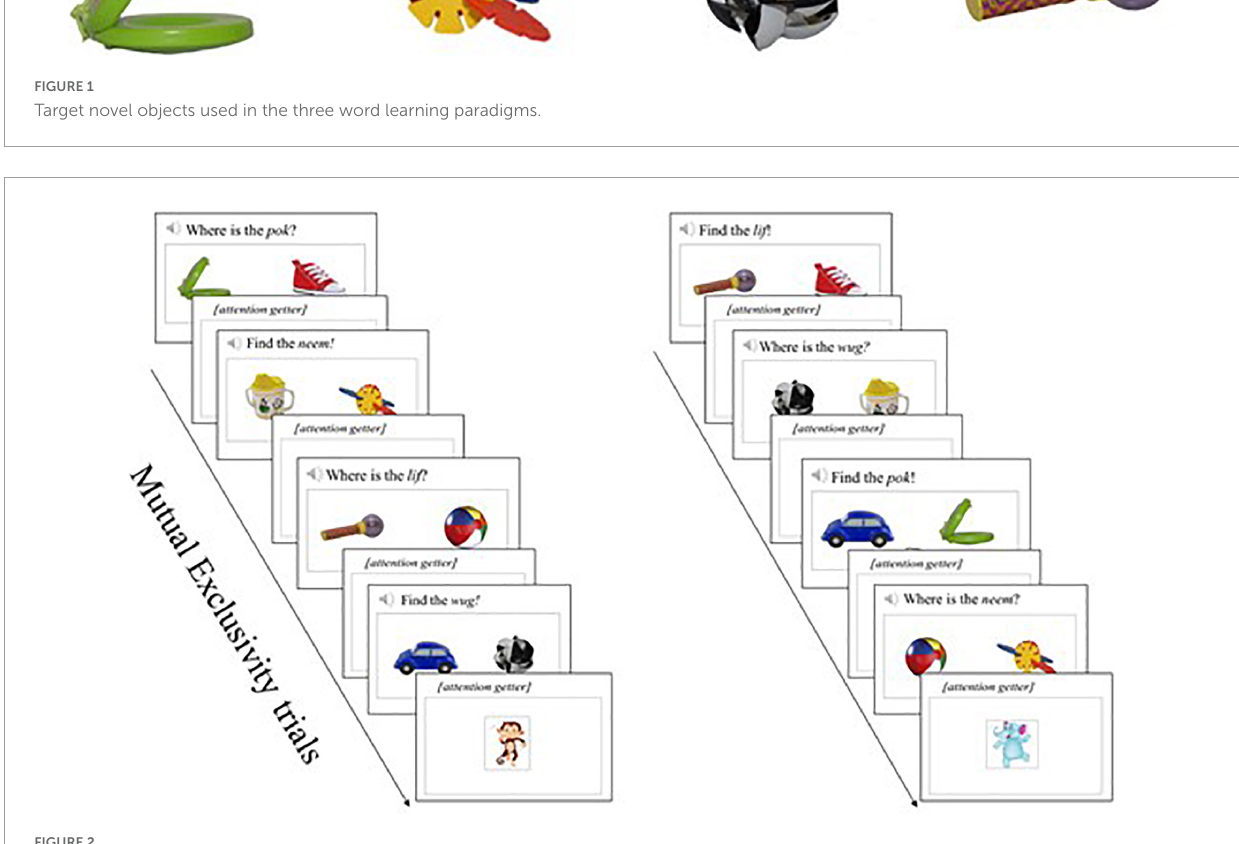
FIGURE2 Illustration of mutual exclusivity